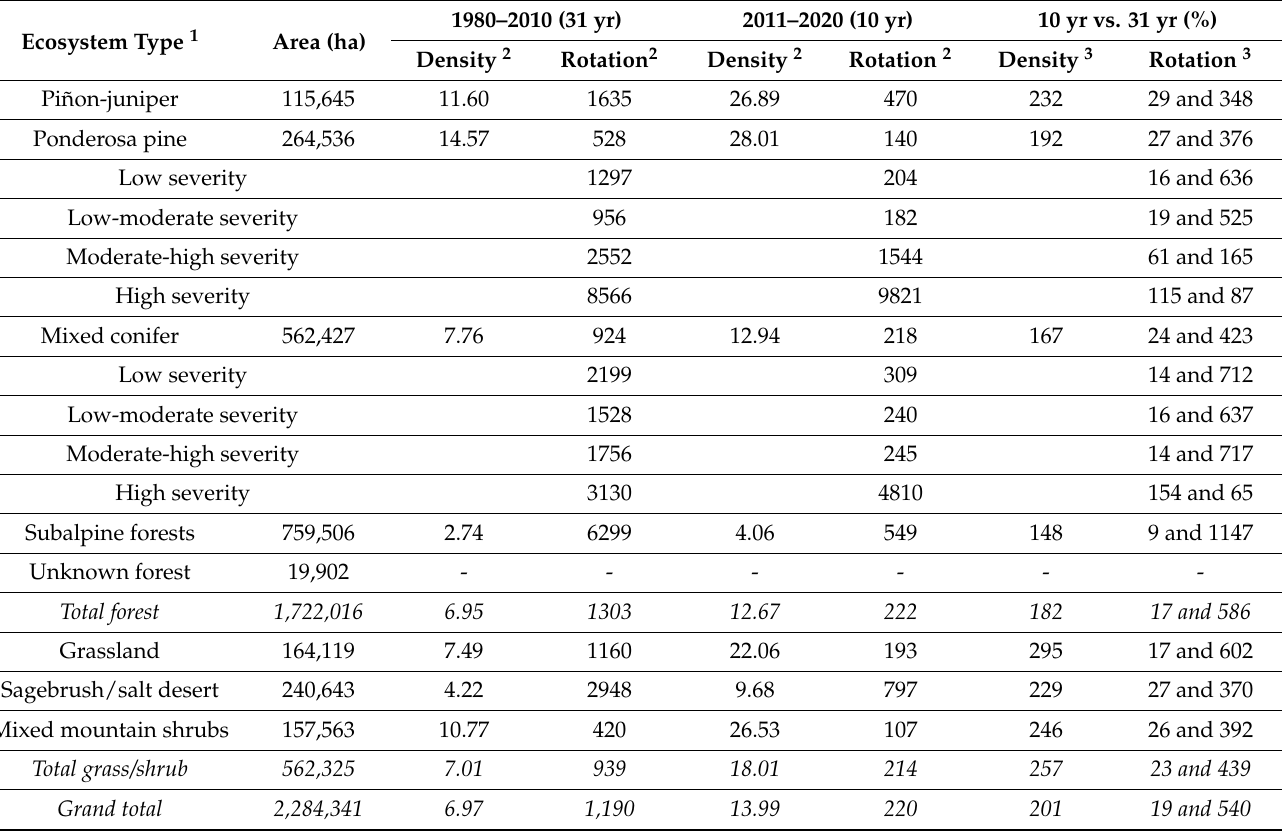
Table 4. Estimated wildfire density and rotations for 1980–2010 (31 years) compared to 2011–2020 (10 years) by ecosystem type and overall. Alternative fire-severity estimates are given for ponderosa pine and mixed conifer, where fire severity was especially historically